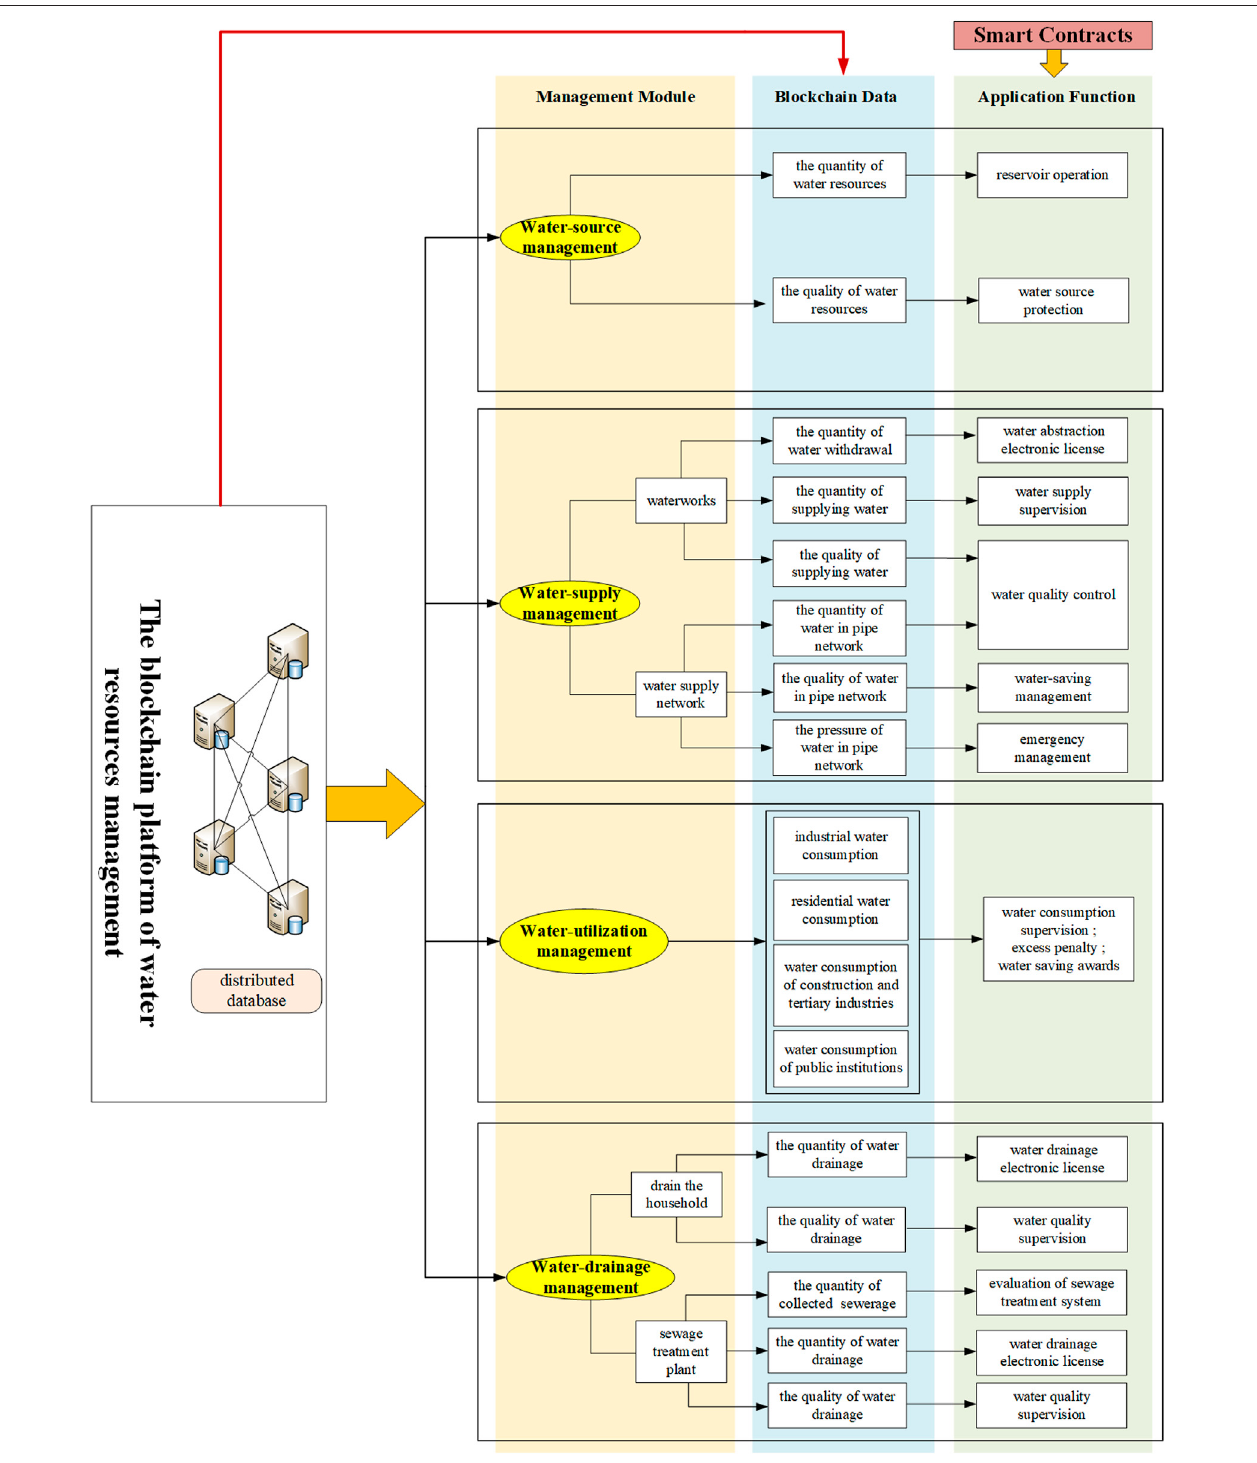
FIGURE 2 | Function modules of the water management application platform based on blockchain.